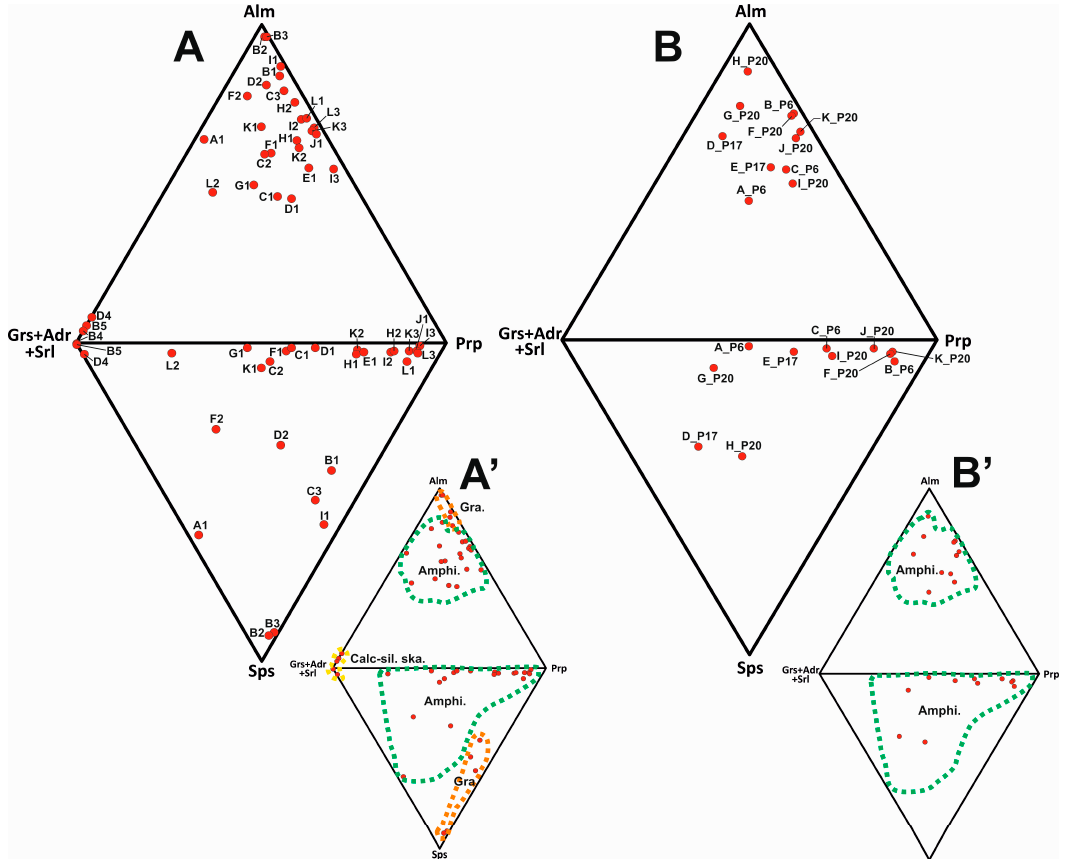
Figure 12. Ternary plots using end-members grossular (Grs) + andradite (Adr) + schorlomite (Srl), almandine (Alm), pyrope (Prp), and spessartine (Sps). A shows the results corresponding to several samples collected from the Northern Portuguese continental shelf (first set of chemical composition data obtained by [10]). The capital letter next to each red dot indicates the location of the sample on the map of the Figure 10. The number next to the capital letter is the reference to the analyzed mineral grain. B shows the results corresponding to the second set of heavy mineral composition data (samples collected from the Porto canyon head area). In this case the capital letters represent each analyzed mineral grain. Each sample is referenced by the letter P followed by a number. The location of the samples is shown in Figure 11. A’ and B’ are the ternary plots showing sub-areas characteristic of garnets with different protoliths: Gra—granites, Amphi—amphibolites, Calc-sil. ska—calc-silicate skarns.